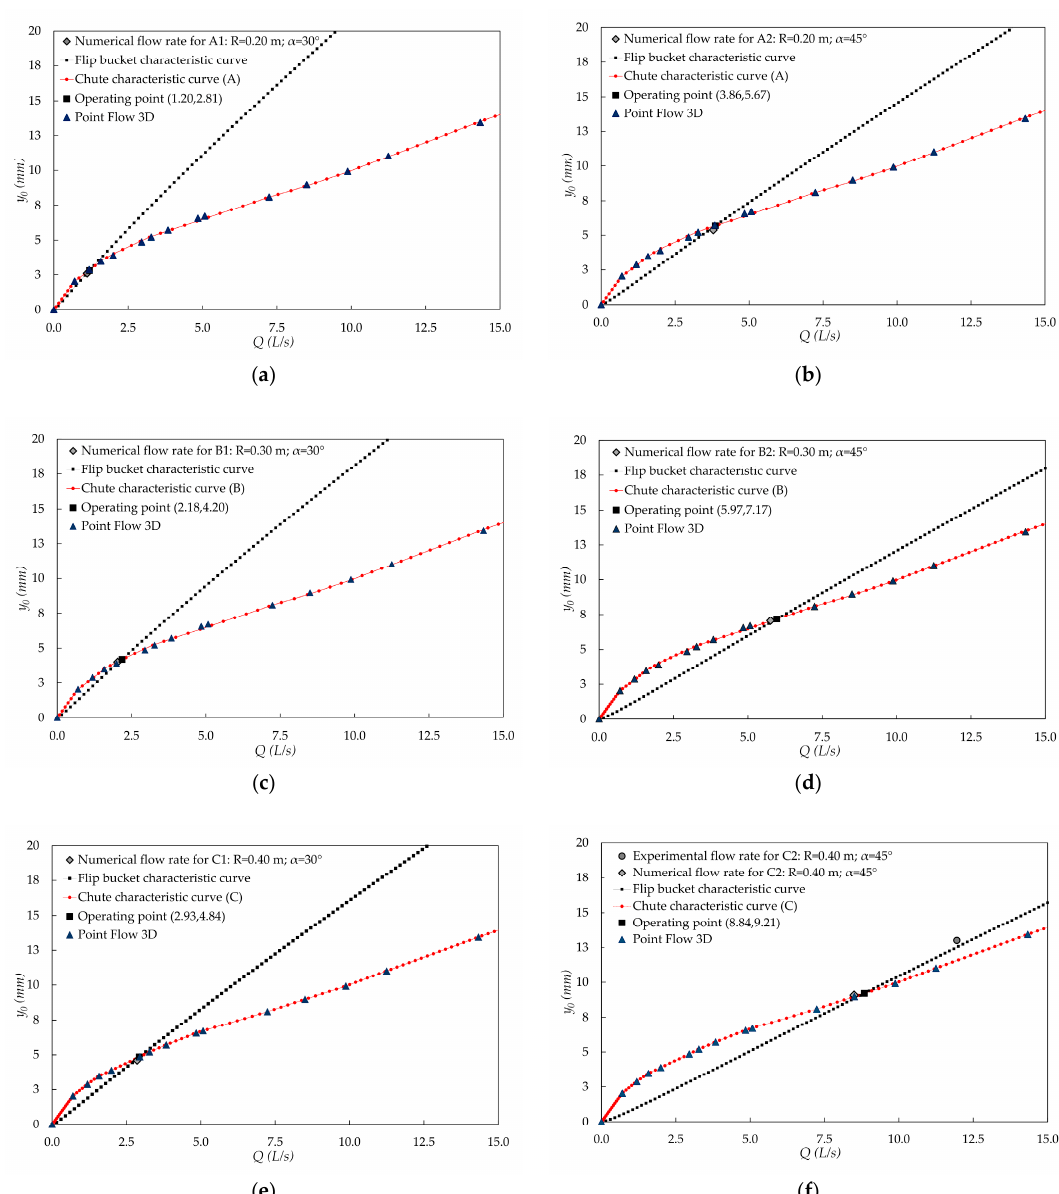
Figure 13 . Characteristic curves and operating point of the chute-flip bucket system: ( a ) A1 ( R = 0.2 m; α = 30°); ( b ) A2 ( R = 0.2 m; α = 45°); ( c ) B1 ( R = 0.3 m; α = 30°); ( d ) B2 ( R = 0.3 m; α = 45°); ( e ) C1 ( R = 0. 4 m; α = 30°); ( f ) C2 ( R = 0.4 m; α = 45°).